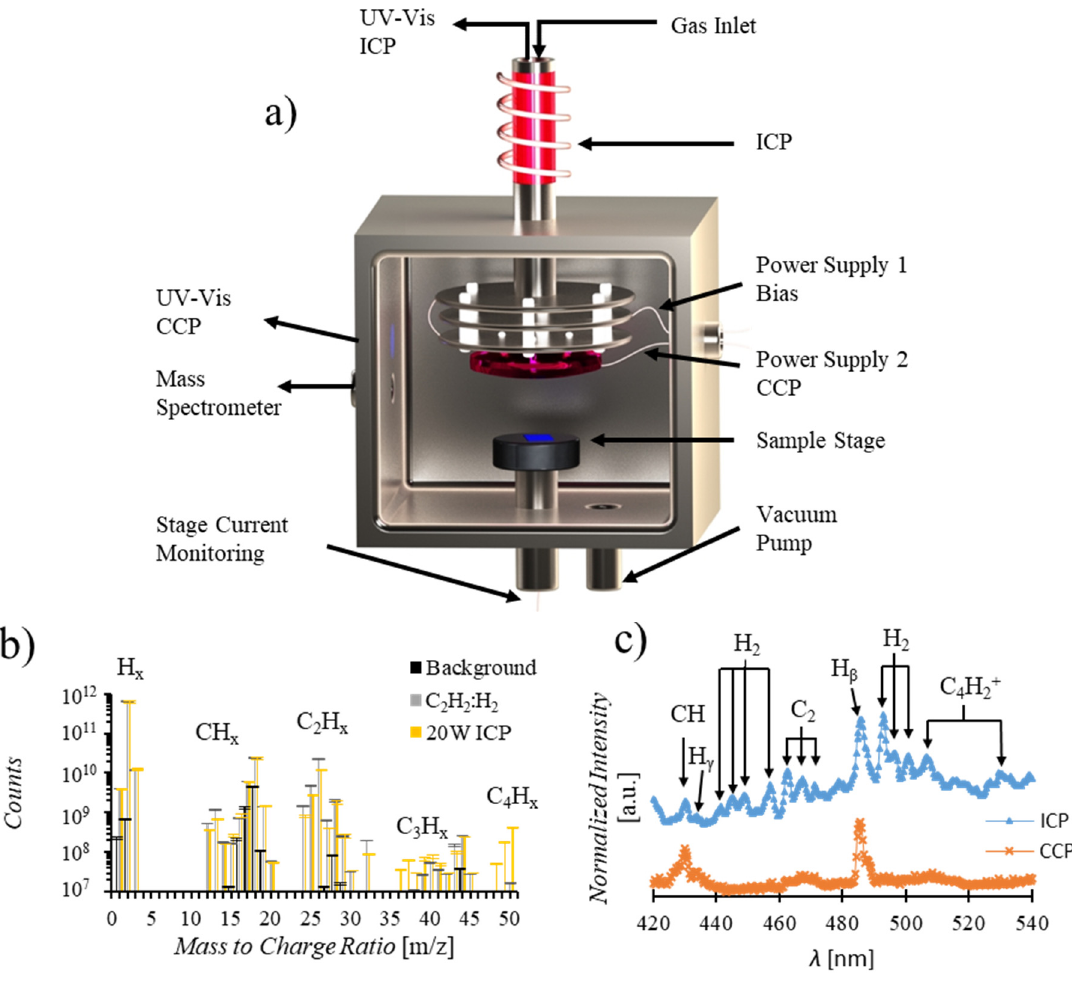
Figure 1. ( a ) Schematic of custom plasma enhanced CVD (PECVD) system with configurable inlet enabling ion screening and secondary plasma generation as well as stage current monitoring, mass spectrometry, and UV-Vis spectroscopy. ( b ) Mass spectrum indicating chamber background (in black) composition is primarily H 2 O and CO 2 ( m / z 18, 28, 44). Gas introduction, C 2 H 2 :H 2 in a 0.1:15 ratio (displayed in grey), results in increased detection of 1 and 2 carbon containing species ( m / z 13–16, 24–26) while 20W inductively coupled plasma (ICP) ignition (displayed in yellow) results in the detection of 3 and 4 carbon species ( m / z 36–39, 47–50). ( c ) UV-Vis spectrum collected for a 20W ICP (shown in blue) and a 2.5W capacitively coupled plasma (CCP) (shown in orange) indicate the increased diversity of both hydrogen and carbon signals present at the higher powered ICP while primarily H β and CH ionization events occur in the low power CCP.